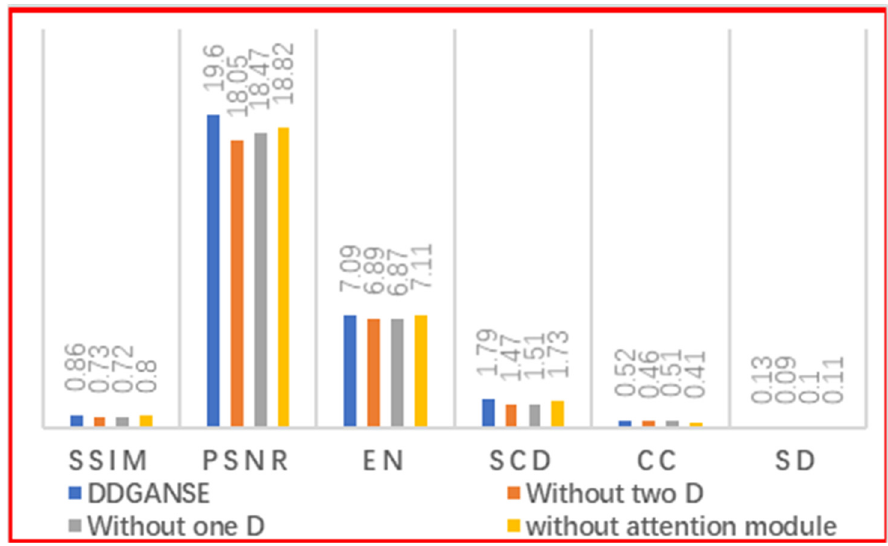
Figure 11. Quantification results for DDGANSE for different performance metrics. Table 4. Average running times of different methods (unit: